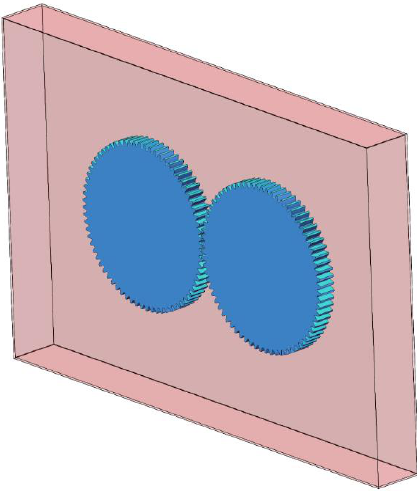
Figure 4. Fluid domain of a gear pair.